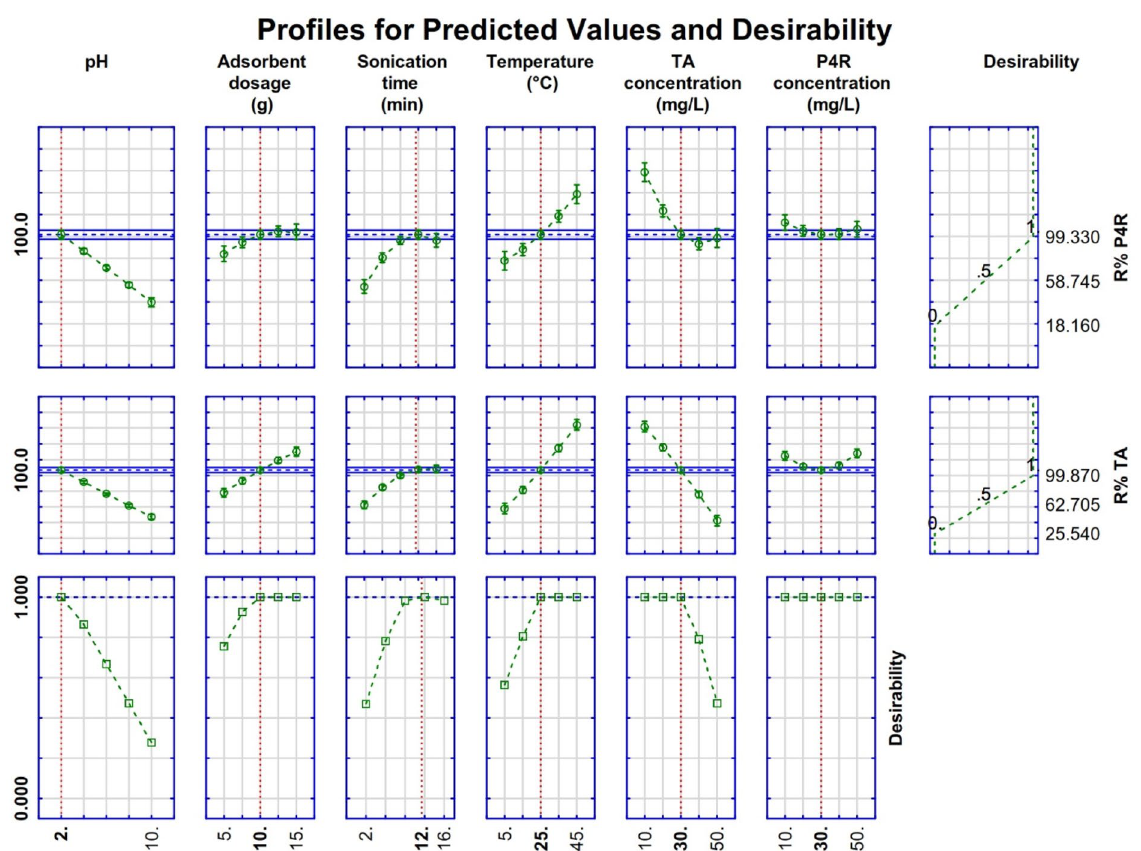
Figure 9. Profiles for predicted values and desirability function for the maximum R % of dyes. Dotted red lines indicate the optimization